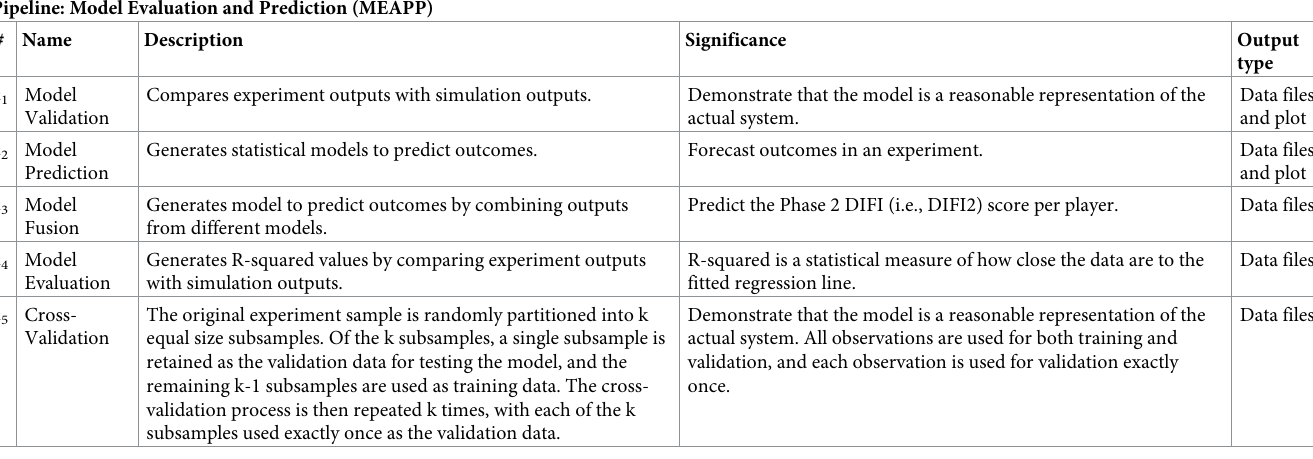
Table 13. Listing of types of functions as microservices for the (5) Model Evaluation and Prediction pipeline (MEAPP). Pipeline: Model Evaluation and Prediction